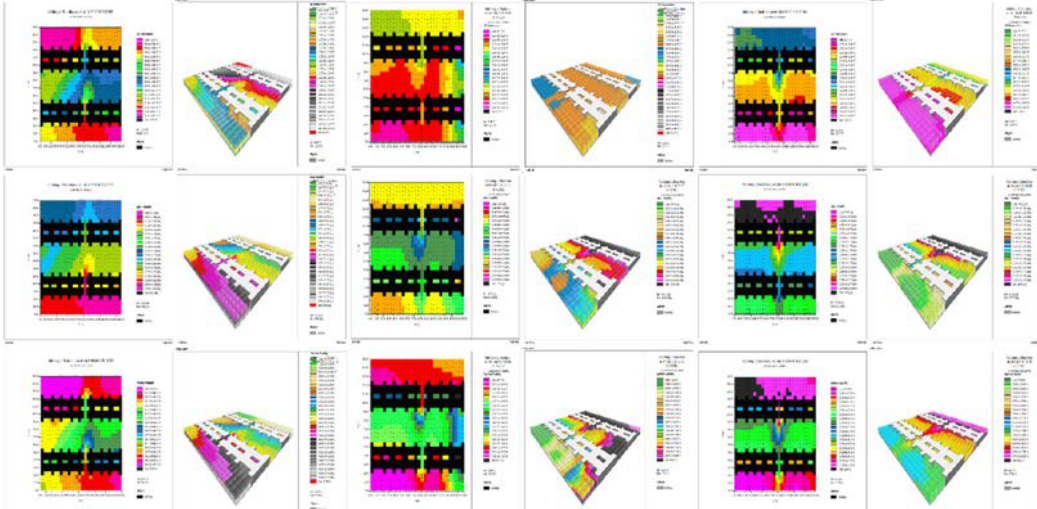
Fig. 6: 3D thermal model and map, specific humidity and relative humidity resulting from simulation of the hottest, coldest and sultry day of the year for slab housing